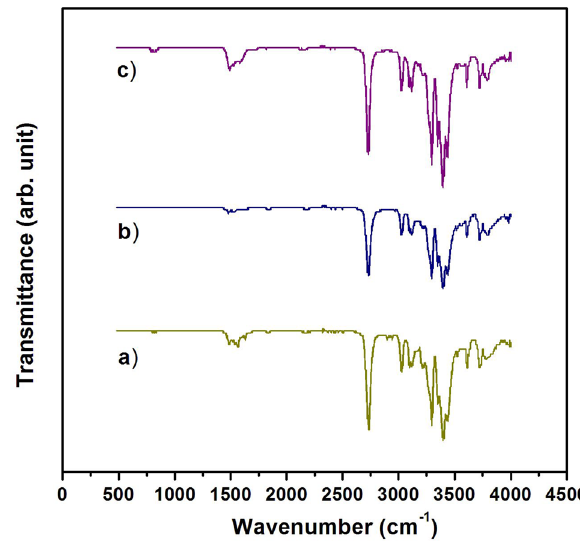
Figure 5. FTIR spectra of the PLA: ( a ) Initial; ( b ) once and ( c ) three times reconstituted from recycled PLA- PCB